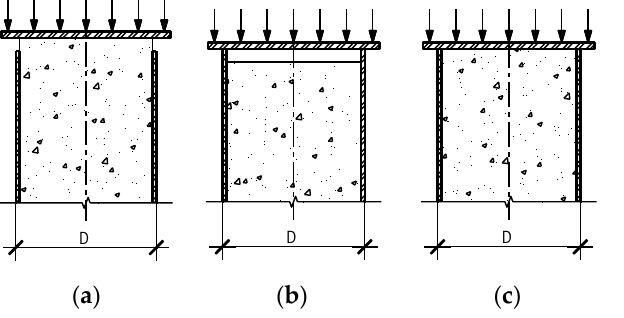
Figure 5. Applied stress on plane section of CFT: ( a ) stress on concrete core, ( b ) stress on steel tube, ( c ) stress on composite member.